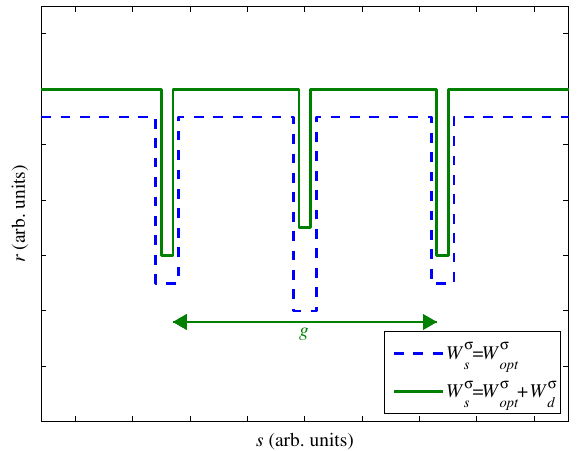
FIG. 9. Geometry examples that require one (dashed) or two (solid) kinds of singular models included in W (cid:1)